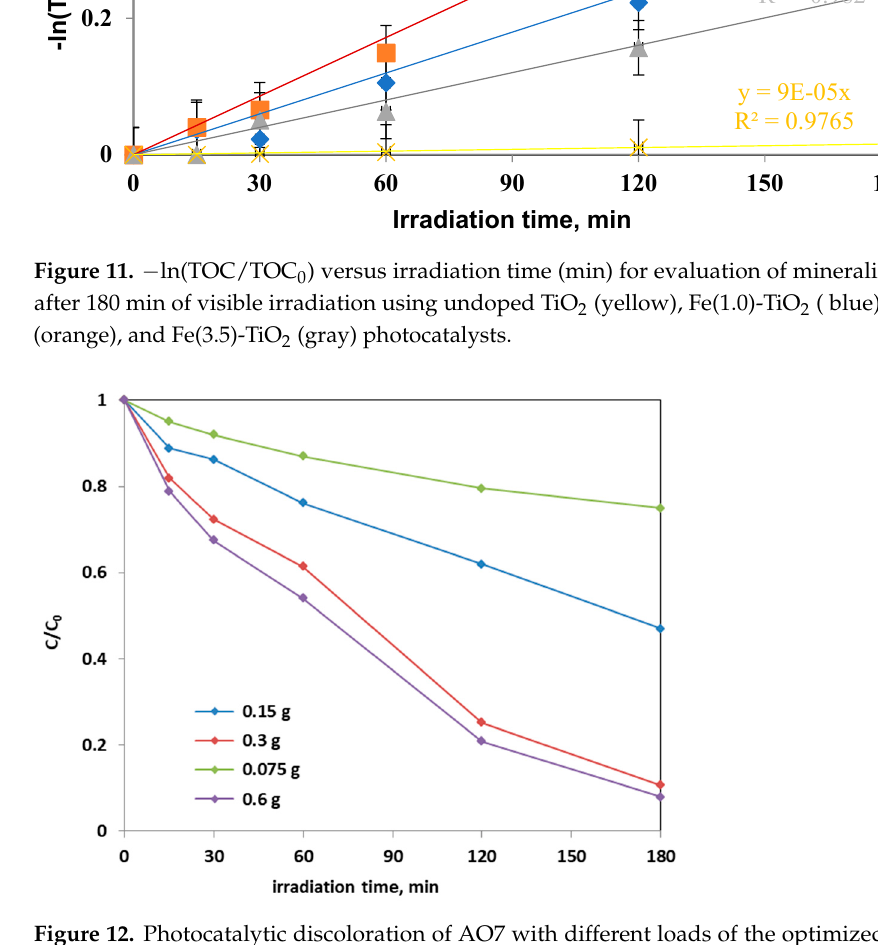
Figure 11. − ln(TOC/TOC 0 ) versus irradiation time (min) for evaluation of mineralization kinetic after 180 min of visible irradiation using undoped TiO 2 (yellow), Fe(1.0)-TiO 2 ( blue), Fe(2.5)-TiO 2 (orange), and Fe(3.5)-TiO 2 (gray) photocatalysts.